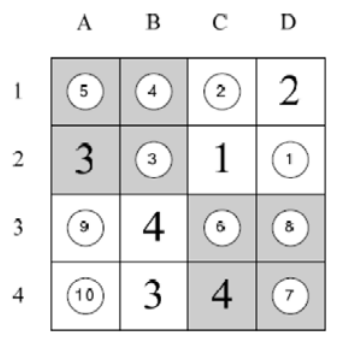
Definition of Sudoku Problem-solving Order (source: compiled by this